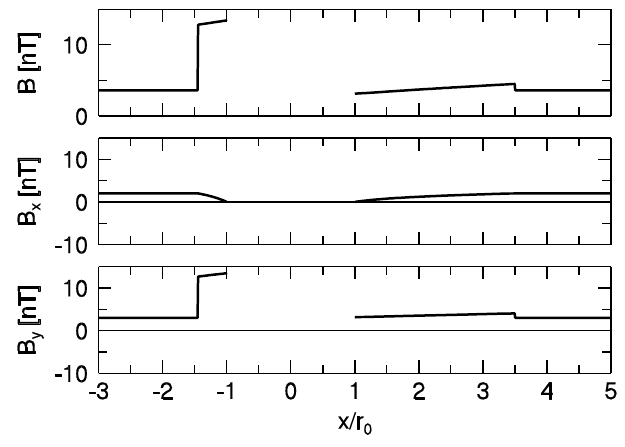
Fig. 6. Model magnetic field magnitude and components at 1AU for 20 November